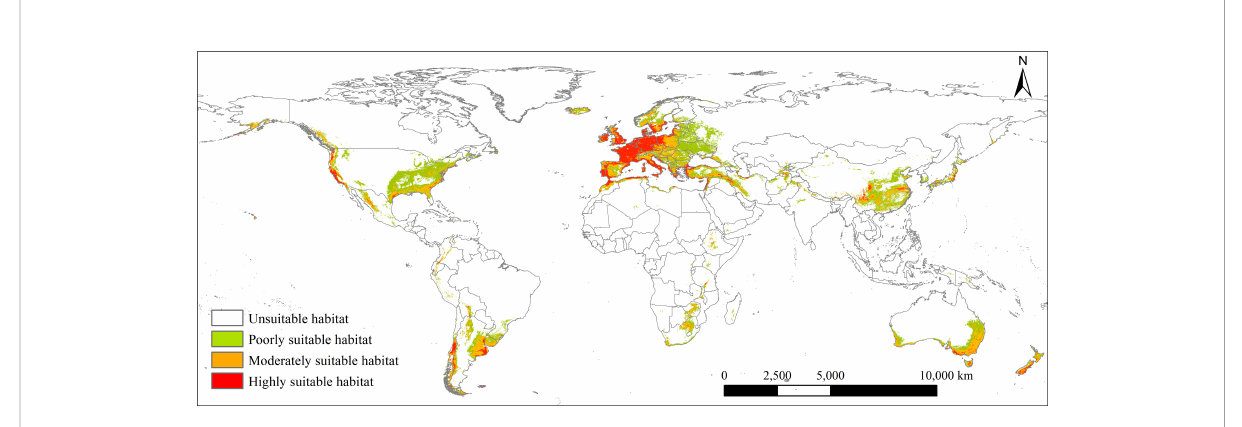
FIGURE 2 Current potential global geographical distribution of Lolium